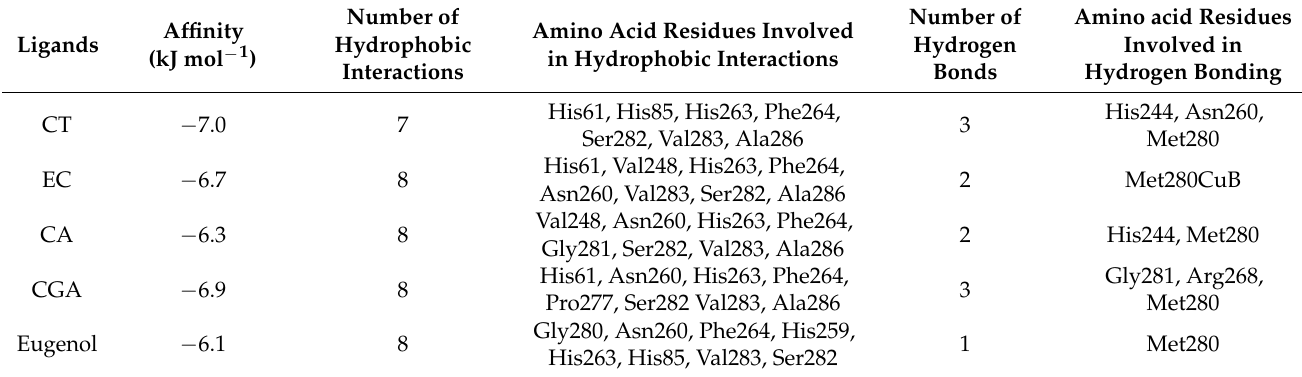
Table 2. The affinity of four compounds and eugenol with tyrosinase and the amino acid residues involved in hydrophobic interactions and hydrogen bonds with four